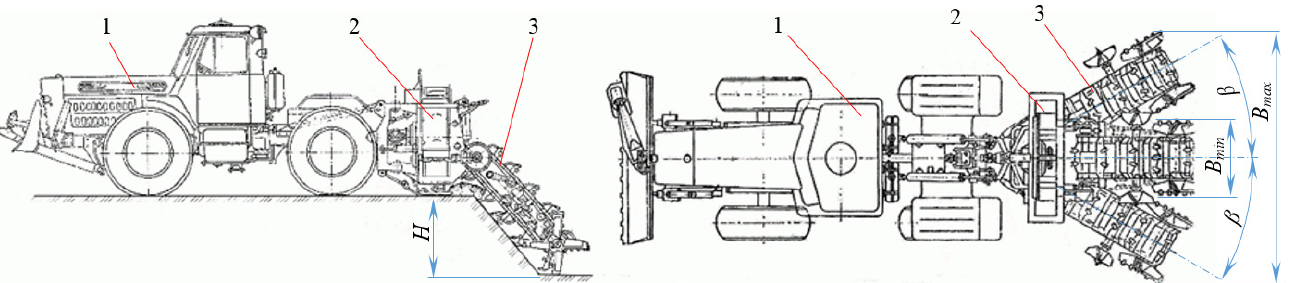
Figure 1. Machinery for digging trenches of variable width: 1—basic tractor; 2—rotary soil evacuator; 3—chain soil development actuator; H —digging depth; B min —the minimum excavation width; B max —the maximum excavation width; β —the angle of rotation of the actuator.